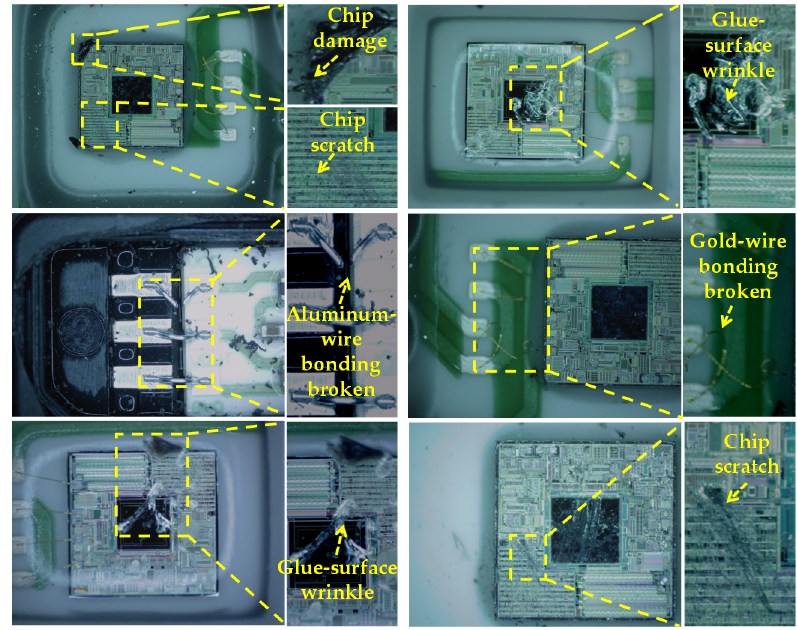
Figure 3. Five kinds of defect images of the MEMS pressure sensor from direct observation.